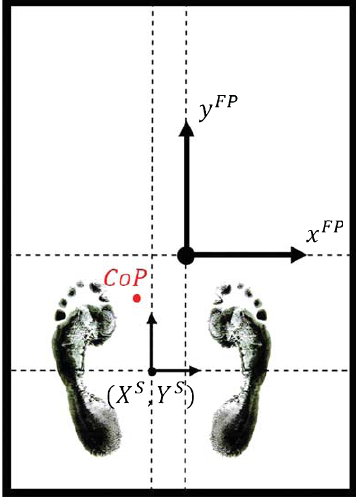
Fig. 4. Difference between force plate and subject reference